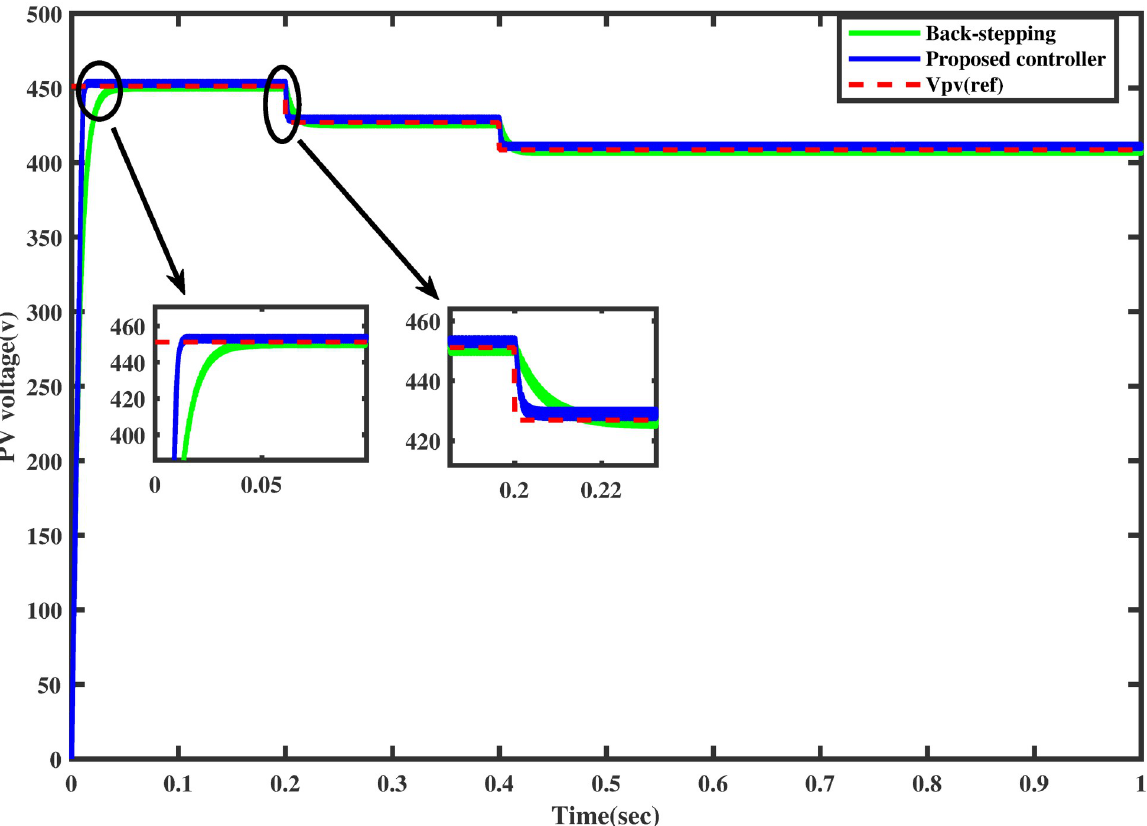
Fig 18. Comparison of PV array voltage under varying